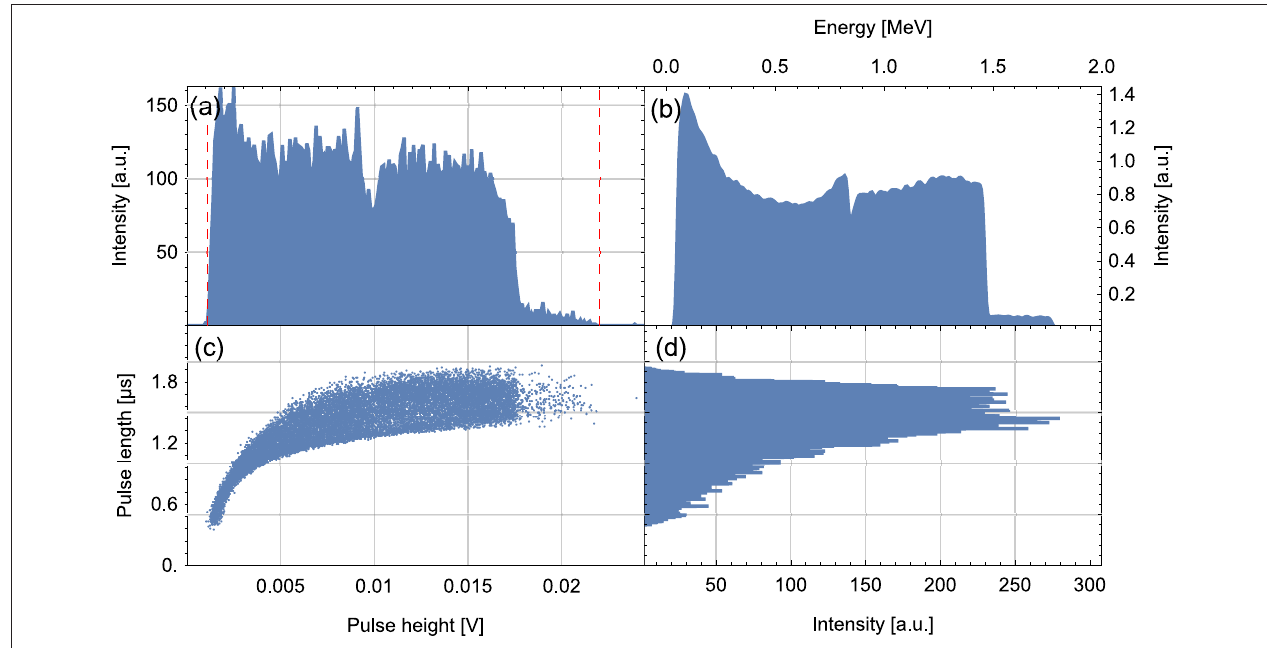
FIGURE 9 | Pulse shape analysis for a boron-lined detector at a counting gas pressure of 250mbar. A total of height spectrum and (b) a reference pulse height spectrum simulated by the URANOS Monte Carlo tool for a 1.44 µ m thick boron layer. The first red line in (a) shows the hardware threshold discrimination to lower energies. The second red line symbolizes the upper threshold as it is set for detecting cosmic-ray neutrons for soil moisture measurements. In this setup, higher energy particles were also recorded in order to estimate the total background noise. (c) Shows the two-dimensional pulse shape data and the event pulse lengths are plotted as a histogram in (d) .